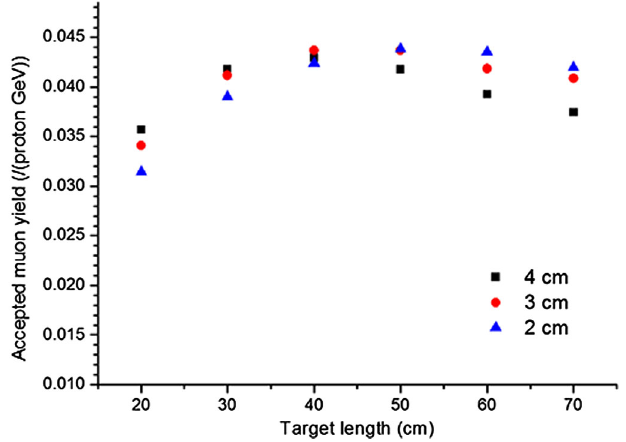
FIG. 14. Desired muons yields (per proton per GeV) of 8 GeV proton beam for different outlet widths for MOMENT as a function of target length.